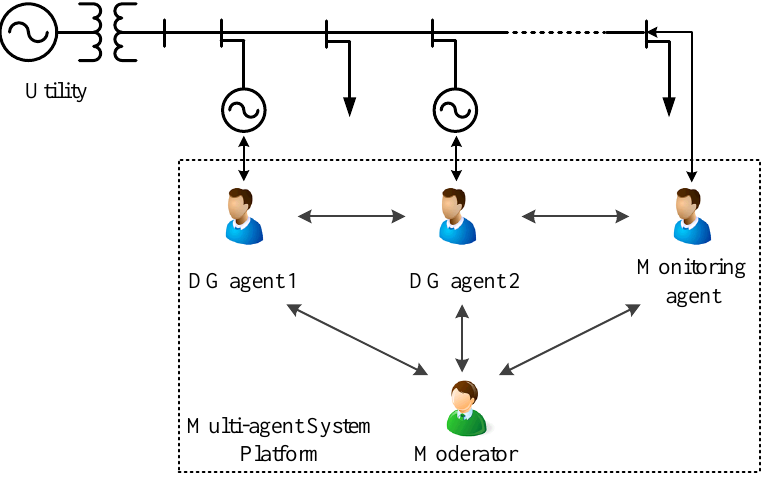
Figure 1. Schematic diagram illustrating the structure of the multi-agent system